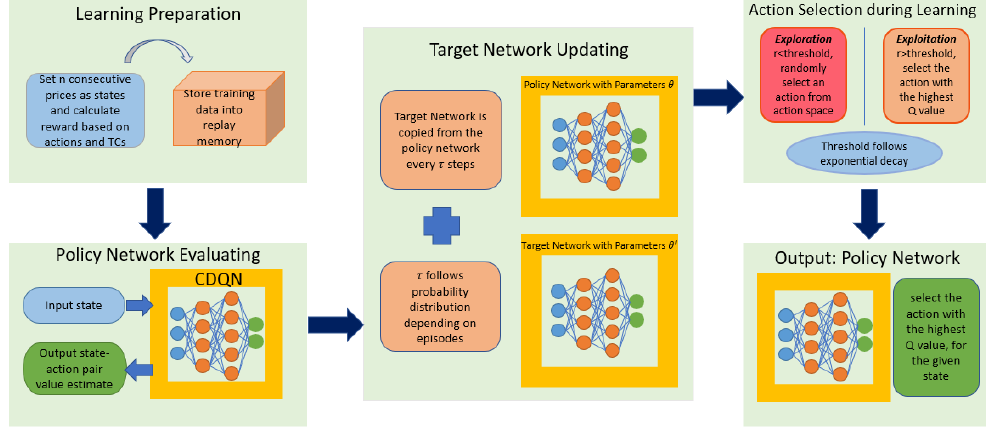
Figure 2. The proposed convolutional deep Q-network (CDQN) with random perturbation (rp), that is, CDQN-rp algorithm for quantitative trading. First we store the (current state, next state, action, reward) tuples into the replay memory. The reward is then calculated based on the transaction costs (TCs) that we have modeled. Next, a sample from the replay memory is used to train the CDQN. During the training process, we apply the rp technique to update the target network. The action selected during the learning is based on both exploration and exploitation with the exploration rate following exponential decay. For decision making, we, or rather the agent, would select the action with the highest Q value for a given